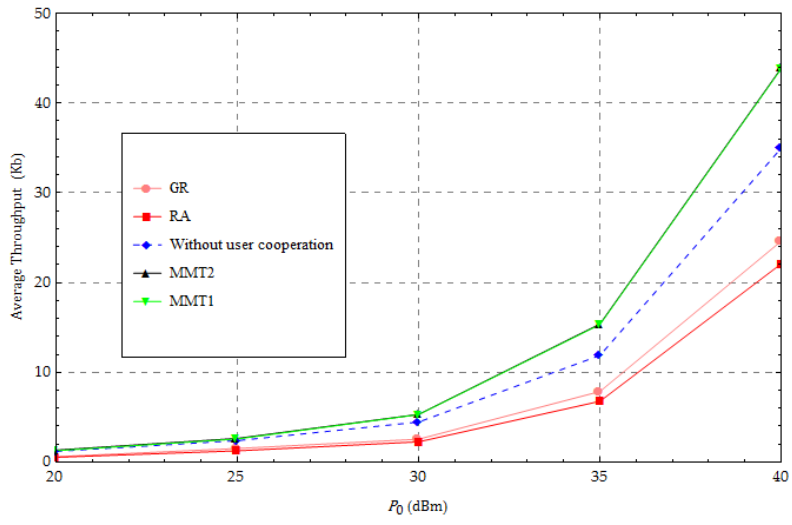
Figure 6. Change in the transmission power of the hybrid access point.